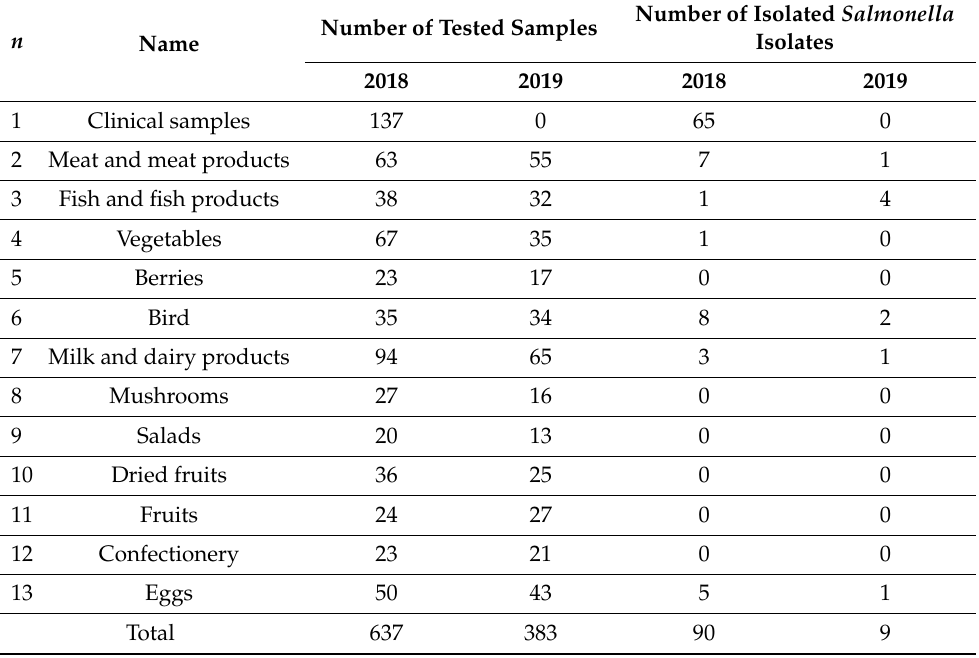
Table 1. List of biological samples collected in 2018–2019 in Almaty for the isolation of